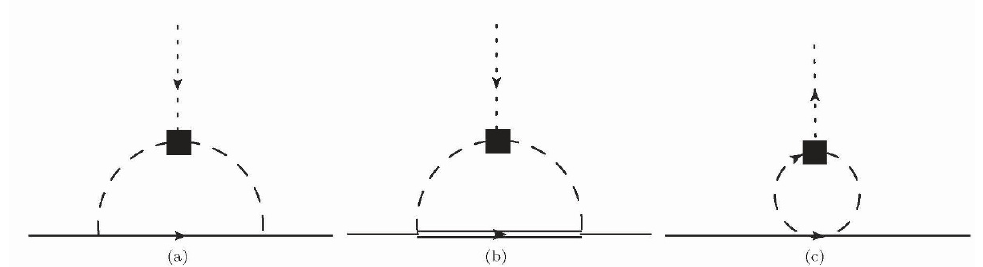
Figure 1 . Diagrams contributing at one-loop to the coupling between η , η ′ and ground-state nucleons. (a) With a ground-state nucleon intermediate state. (b) With a higher-spin nucleon intermediate state. (c) From pions running in the loop. This last diagram does not contribute due to isospin symmetry. Figure from [81]. figure 1. Diagram (a) has ground-state nucleons as intermediate states while diagram